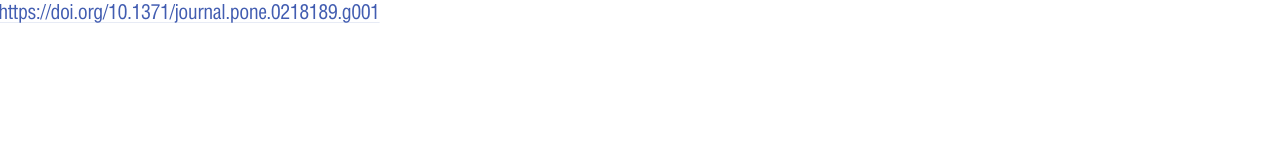
PLOS ONE | https://doi.org/10.1371/journal.pone.0218189 June 10,